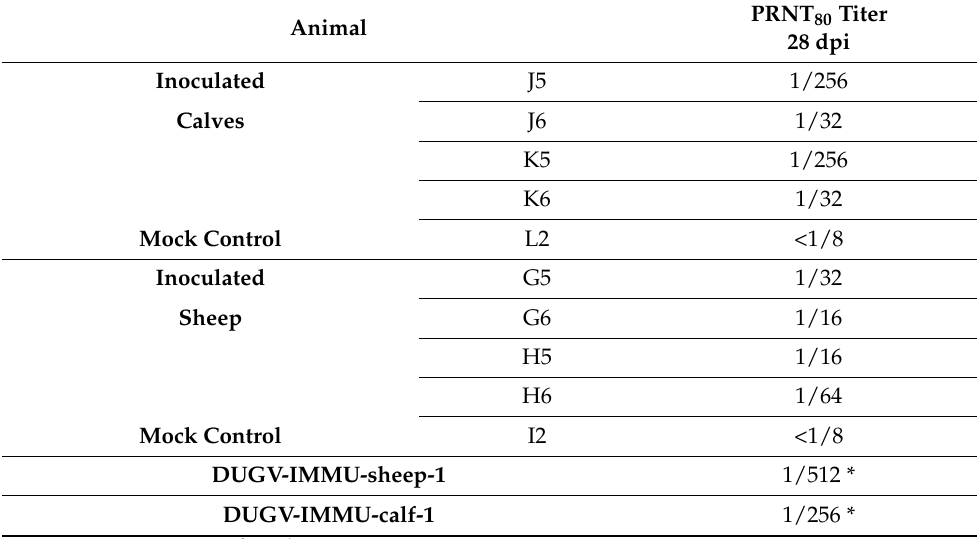
Table 3. PRNT 80 titers of inoculated and immunized animals.